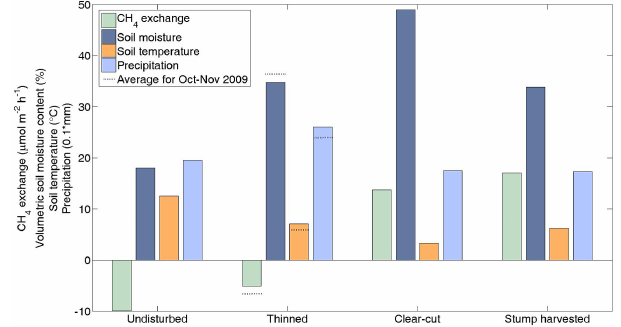
Figure 2. Average CH 4 exchange rates, soil moisture and soil tem- perature at the four sampling plots. Data from the entire measure- ment period at each plot are included. The dashed line at the thinned plot represents average values for October and November, since measurements at the clear-cut and stump harvested plots were con- ducted during this part of the